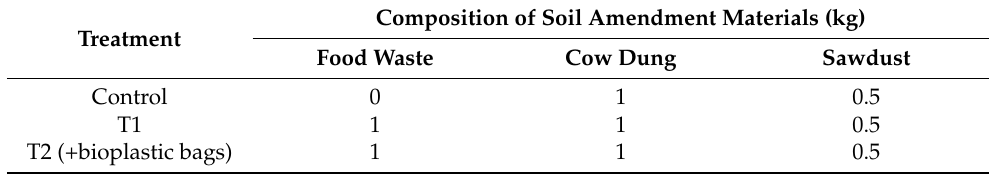
Table 1. Composition of the soil amendment compost in the three experimental conditions examined. Composition of Soil Amendment Materials (kg) Treatment Food Waste Cow